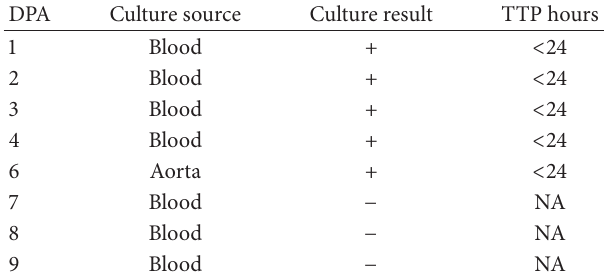
Figure 3: Transesophageal echocardiogram at midesophageal long- axis view with Doppler revealing regurgitation into abscess sur- rounding the aortic valve suggestive of aortic fistula. Table 1: Blood culture results as referenced by days after hos- pital admission with day 1 being the day of admission. Surgical intervention with aortic valve replacement occurred on day 6 of hospitalization. Organism identified in all cultures was Ralstonia pickettii